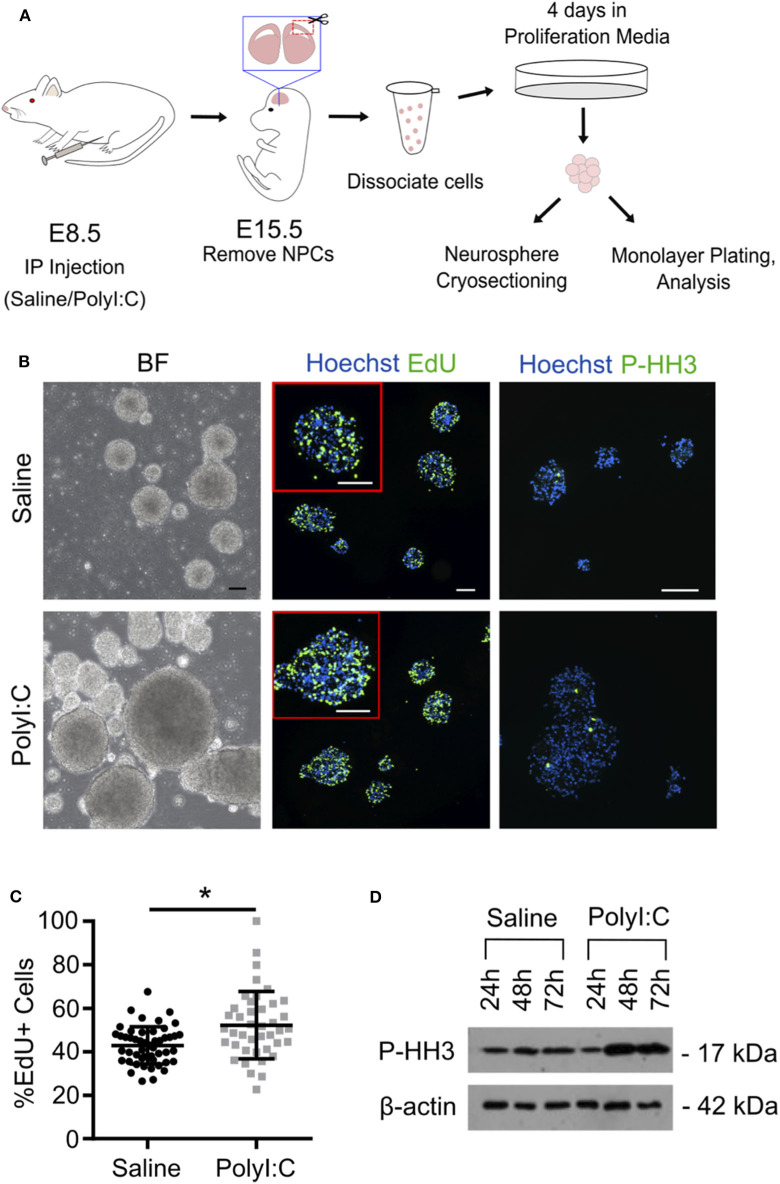
Maternal exposure to PolyI:C increases proliferation potential of neurospheres prepared from fetal cortices. Pregnant rats were administered saline or PolyI:C on E8.5, and NPCs were isolated from E15.5 fetal cortices for neurosphere culture. (A) Schematic depiction of experimental protocol. (B) The two left panels show neurospheres produced from cortical NPCs imaged using brightfield. The middle two panels show EdU incorporation in cryosectioned neurospheres. The right two panels show immunofluorescence for phospho-histone H3 (P-HH3). In the middle and right panels, Hoechst is used to counterstain nuclei. Scale bar = 100 μm. (C) Percent EdU positive cells in each neurosphere were quantified from each treatment group. (D) Western blot analysis of P-HH3 expression in neurospheres following 24, 48, and 72 h culture. β-actin was used as a loading control. Statistical analyses were performed using Student's t-test. Data are represented as mean ± SEM. Data significantly different (P < 0.05) from controls are indicated by an asterisk (*5–6 fetuses from each of 3 dams per treatment were used for neurosphere generation).